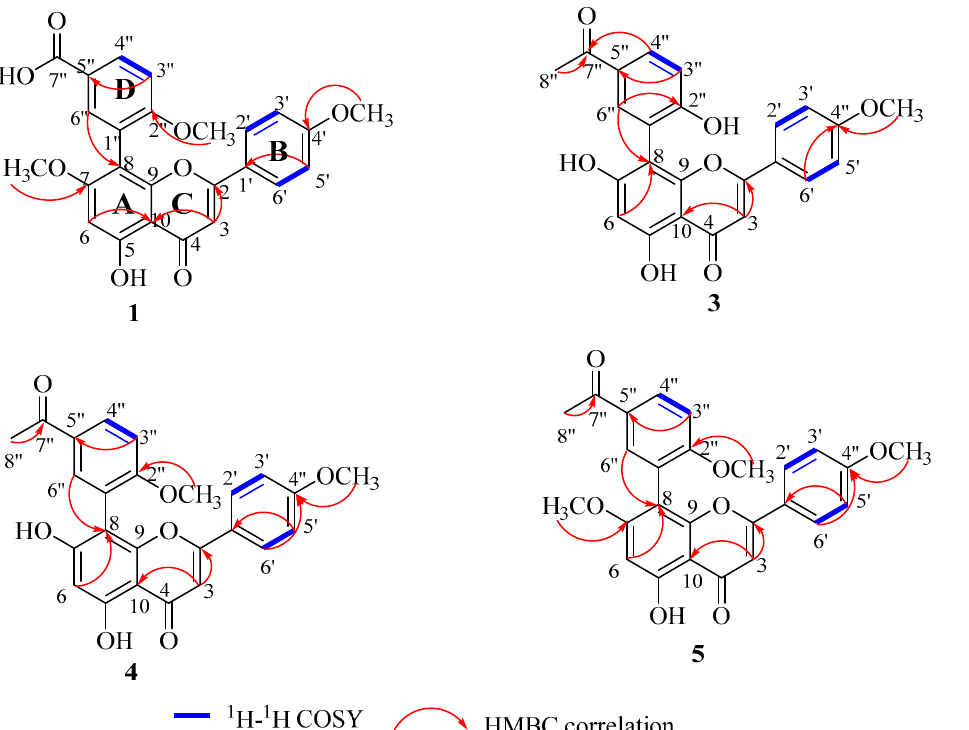
Figure 5. Main 1 H- 1 H COSY and HMBC correlations of compounds 1 , 3 , 4 and 5 .